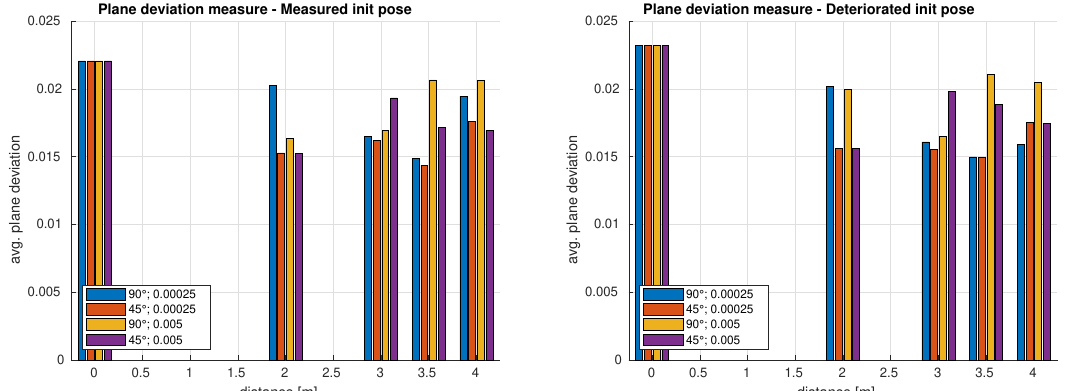
Figure 7. Results of experiments calibrating the LiDARs extrinsic parameters under different circumstances and with different quality measures. The graphs in the left diagram show the quality of recorded point clouds after calibration from a pose we actually measured at the platform construction, rated with the plane deviation (above) and the crispness measure (below). The graphs in the right diagram depict the same ratings but applied to results from an initial pose guess with an artificially upscaled error. All graphs contain ratings of calibration results produced from different target arrangements, each calibrated with a high (0.00025) and a relatively low (0.005) resolution of the pose parameter